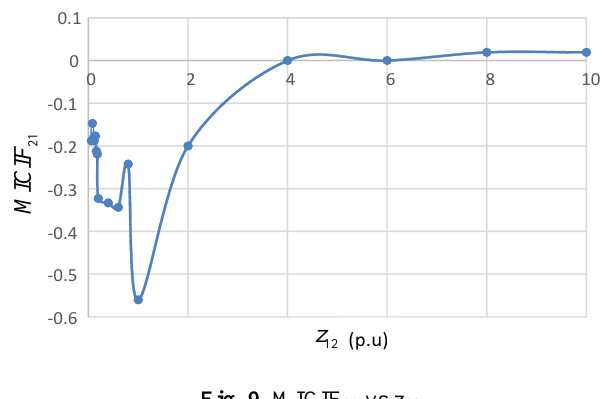
Fig. 9. MICIF 21 vs z